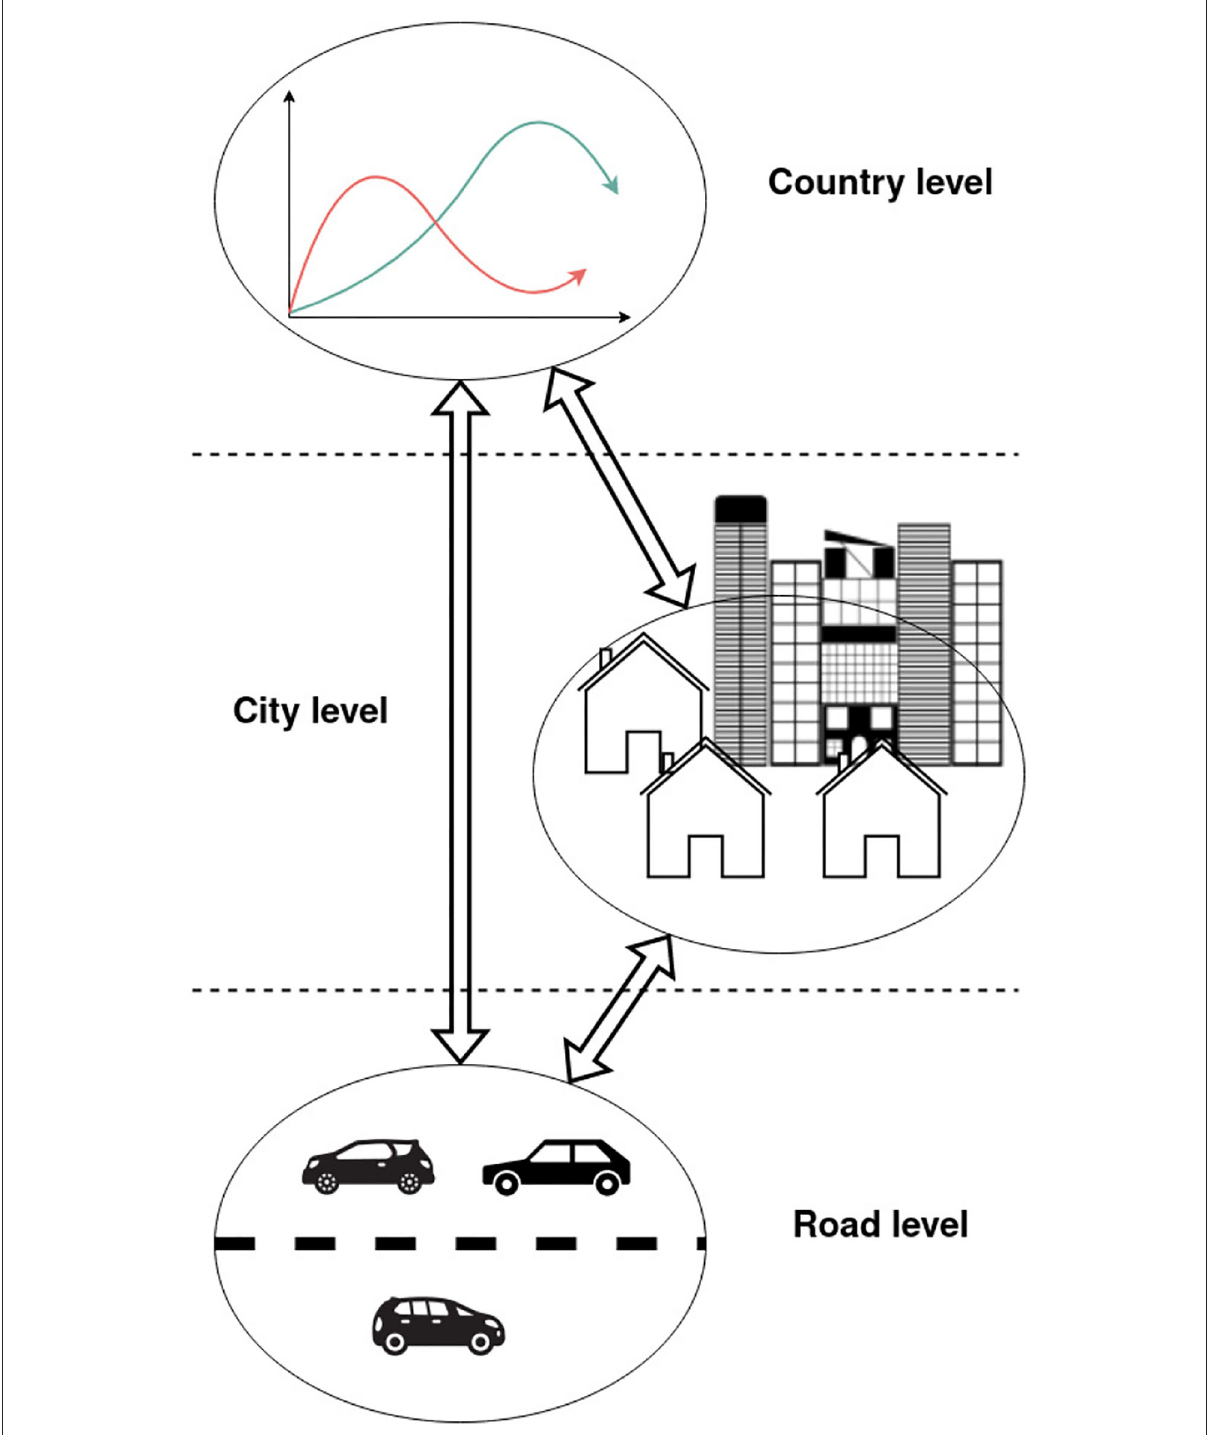
FIGURE6 Simplified representation of the Collaboration